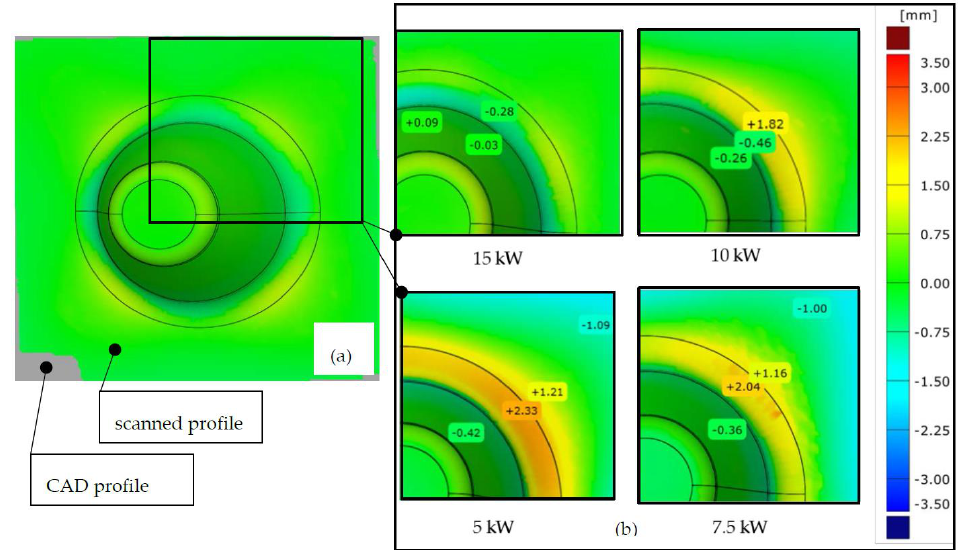
Figure 5. ( a ) 3D geometrical scan compared with CAD profiles formed by 62° cone wall angle; and ( b ) quartered sections showing comparisons for different induction heating powers.